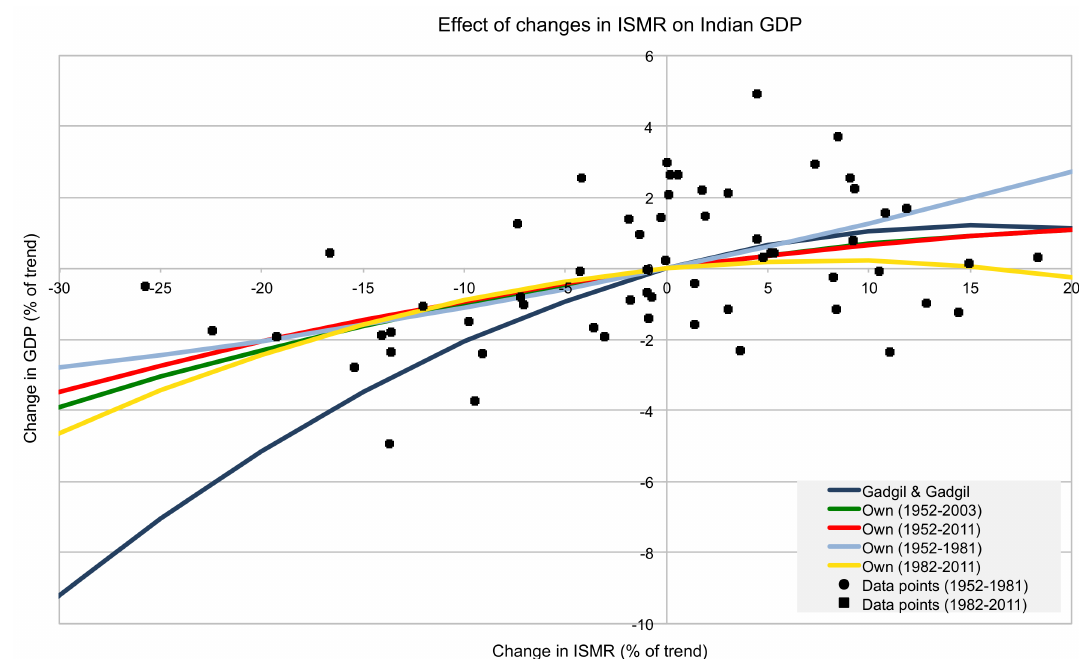
Figure 4. Graph of relationships between ISMR and All-India GDP for five scenarios: (i) the relationship from Gadgil and Gadgil [2006] for data from 1951–2003 (blue); and three (quadratic) relationships we derive using the datasets and methodology described here (ii) for the equivalent period to Gadgil and Gadgil (1951–2003) (green) (iii) using data for 1951–2011 (red); (iv) using the subset of data for 1952–1981 (light blue); and (v) using the subset of data for 1982–2011 (yellow). Annual values are shown for individual years: circles for 1952–1981, squares for 1982–2011—derived from [16,17]).